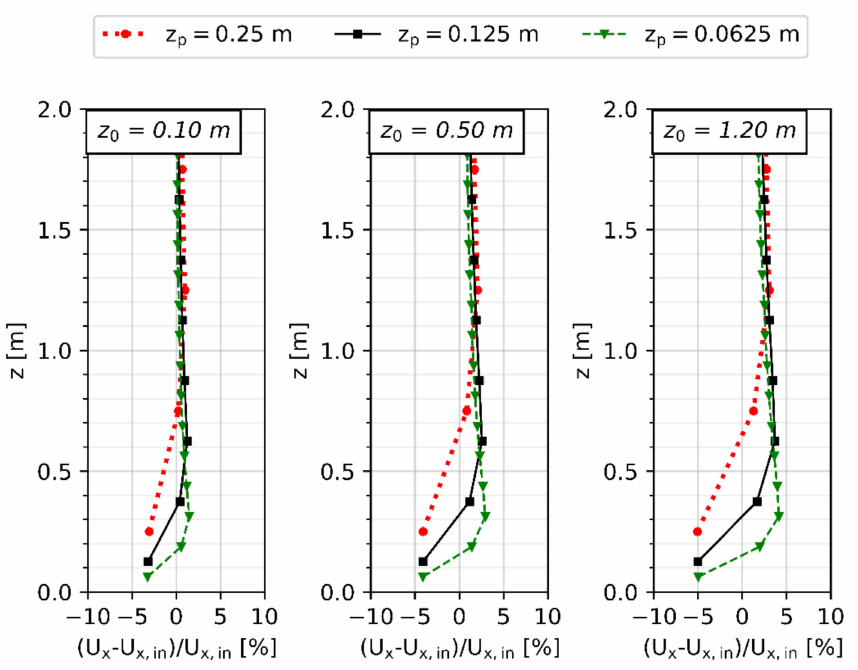
Figure 2. Wind profiles at 300 m distance from the inlet for varying surface roughness and grid resolution.